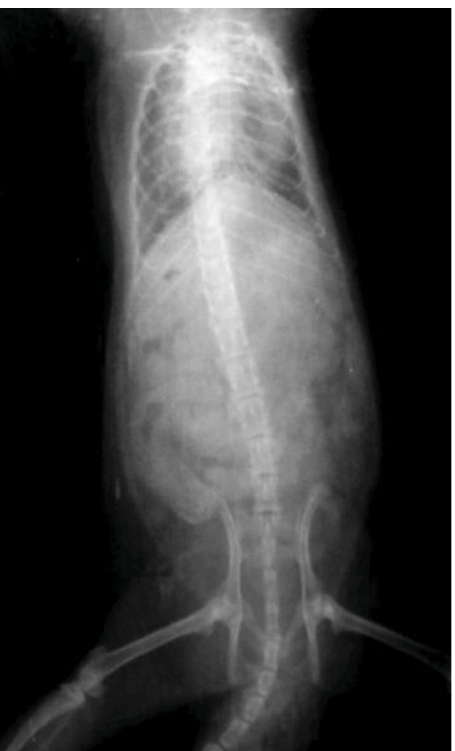
Figure 3. A galantamine-treated rat immediately after CM administration. Typical alternate segments with narrowed (a) and widened (b) lumen in the small intestines are